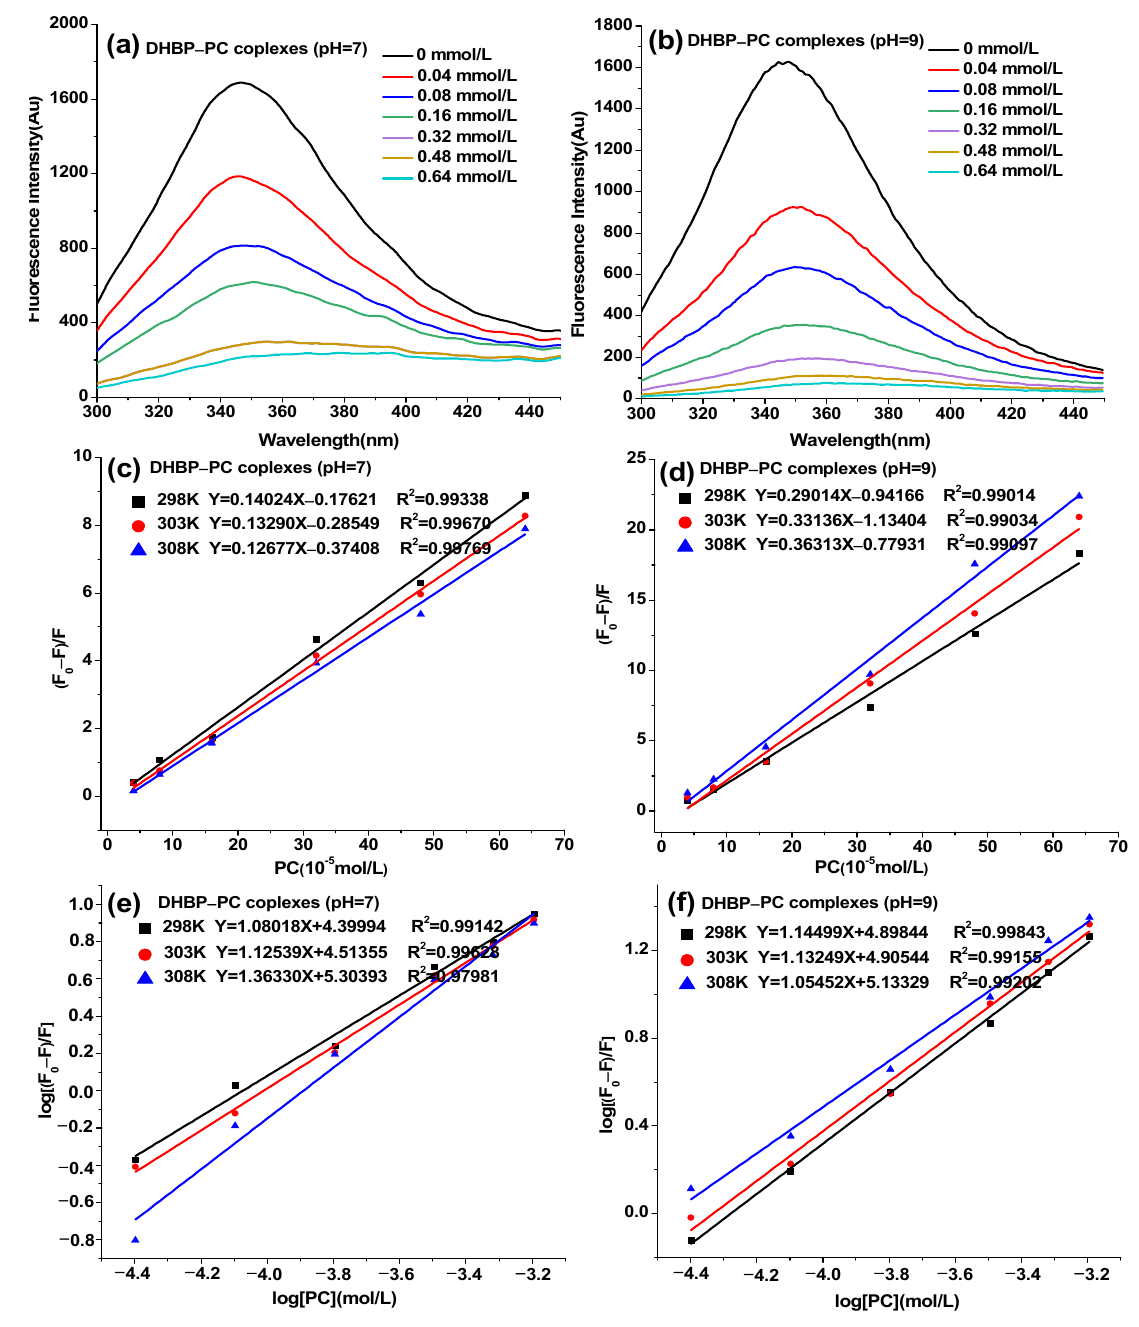
Figure 2. Fluorescence spectrum ( a , b ) and fluorescence quenching mechanism ( c – f ) analysis of decolorized highland barley protein (DHBP)–proanthocyanidin (PC) complexes.